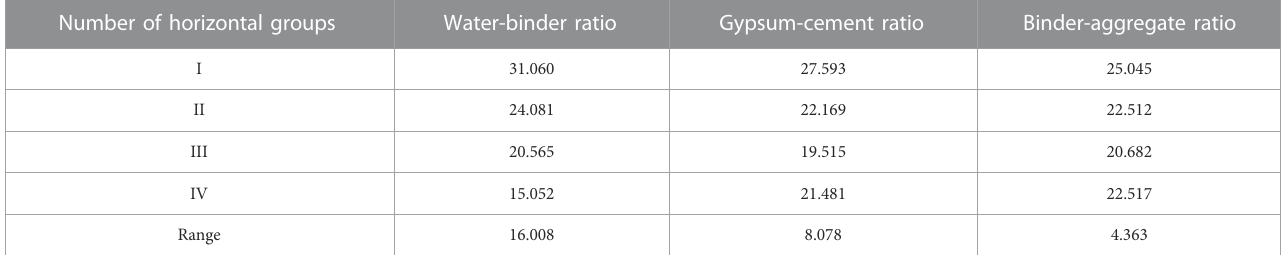
TABLE 5 Compressive strength range analysis